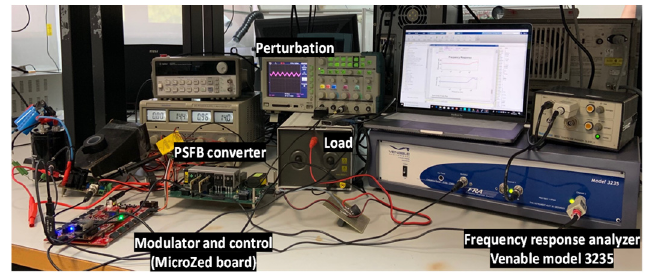
Figure 16. Experimental prototype of the PSFB converter.